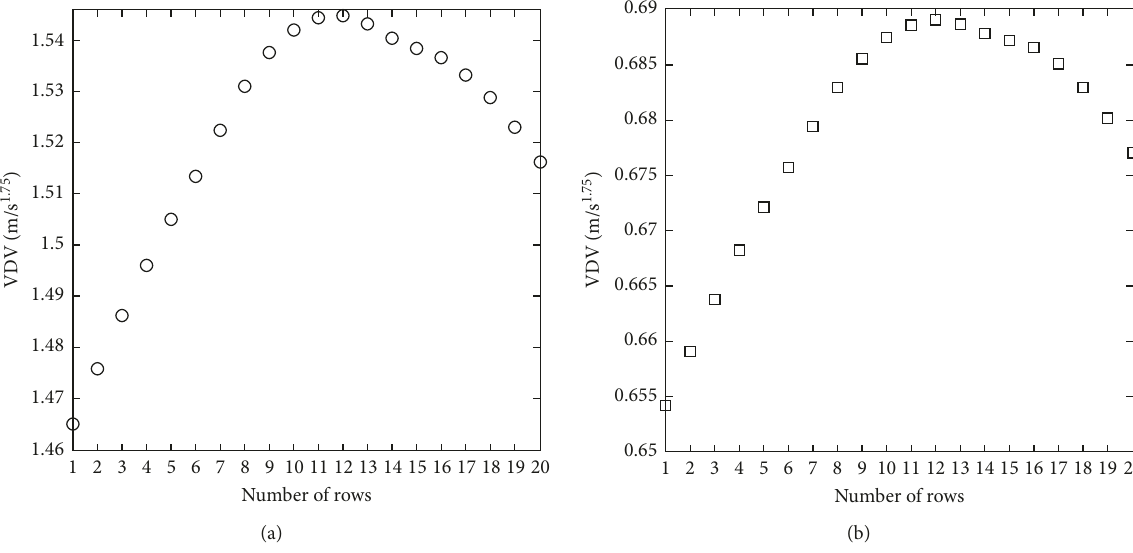
Figure 23: The VDVs of structural seating when 235 persons swaying with 100% synchronism. (a) 235 persons swaying at the same direction. (b) 235 persons swaying at not a same direction.